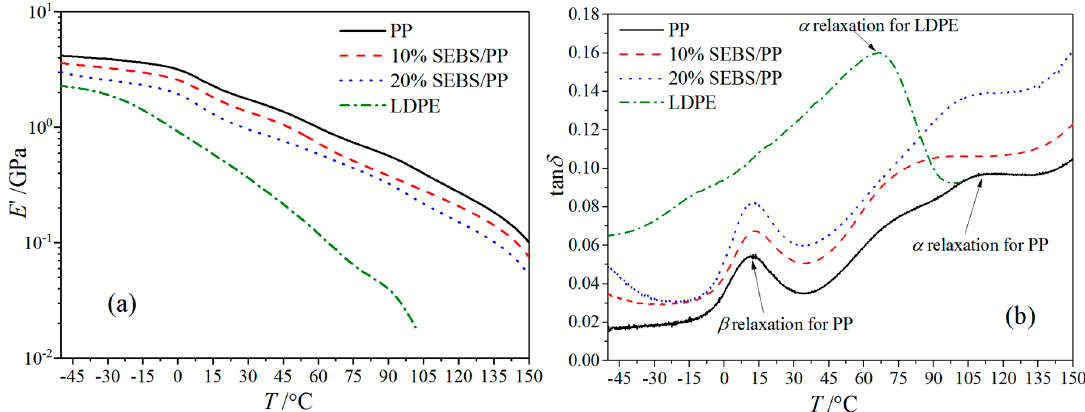
Figure 6. The dynamic thermomechanical analyzer (DMA) temperature spectra of the SEBS/PP composites and LDPE: ( a ) storage modulus and ( b ) loss factor.